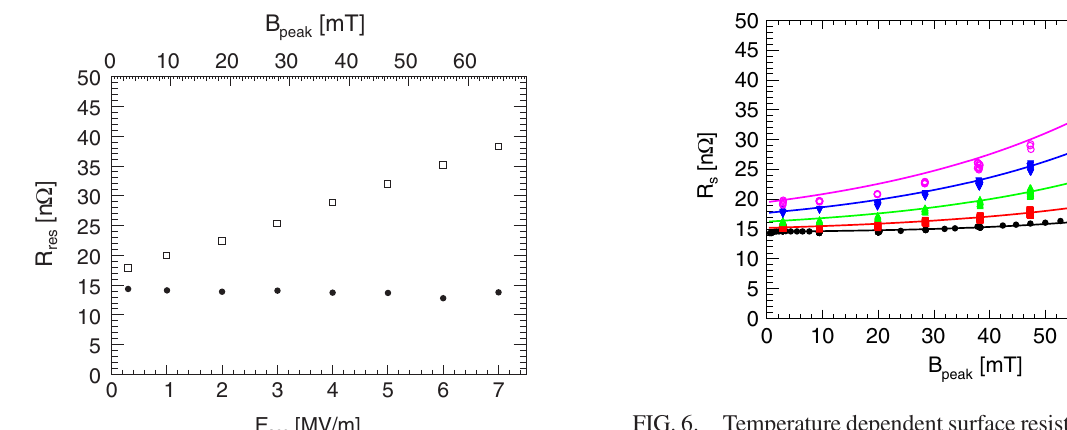
and the squares show R s 0